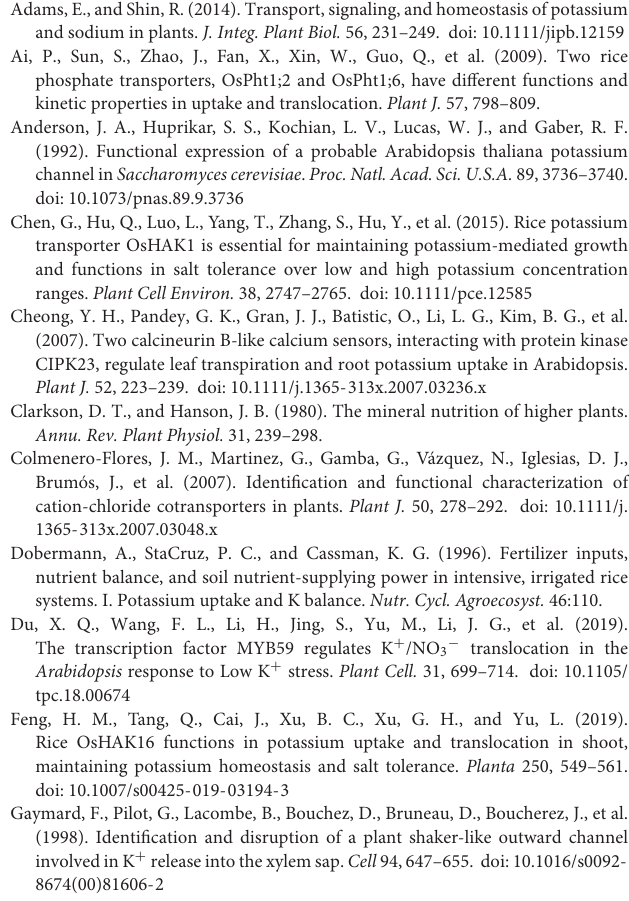
wild-type and Oshak8 mutants ( Oshak8-1 , Oshak8-2 ) ( P < 0.01 by Student’s t -test). The experiment was repeated three times with similar results. Error bars represent ± SD. Supplementary Figure 4 | Quantitative analysis of OsHAK8 promoter activity represented by GUS signal. Histochemical analysis of OsHAK8 promoter-driven GUS reporter expression in transgenic rice plants. Three-day-old rice seedlings ( Nipponbare ) were grown in hydroponic solution containing 10 mM K + for 3 days and then transferred to 10 mM K + ( + K) and 0 mM K + (-K) solutions for 24 h, respectively. GUS activity was examined by staining with GUS substrate (X-Gluc) in three independent lines (#2, #5, #8) of transgenic plants harboring OsHAK8 -GUS construct. Plants were stained in each line and a representative plant was shown in each group. (A) Cross-section images of the root hair zone of the transgenic plants harboring OsHAK8 -GUS construct (#2, #5, #8) in (A) . Bars = 100 µ m. (B) Quantification of GUS activity in the cortex region of transgenic rice plants containing the OsHAK8 promoter-GUS construct in (A) . Image J software was used to quantify the GUS signals in the root cortex areas of the transgenic lines (#2, #5, #8) treated with K + -sufficient (10-mM K + ) or low-K + conditions (0-mM K + ). Three plants from each line were used for the analysis in one experiment. The experiment was repeated three times with similar results. Error bars represent ± SD. Significant difference was found between 0.01- and 10-mM K + samples are indicated in root tissues ( P < 0.01 by Student’s t -test). The experiment was repeated three times with similar results. Error bars represent ± SD. Supplementary Table 1 | List of PCR